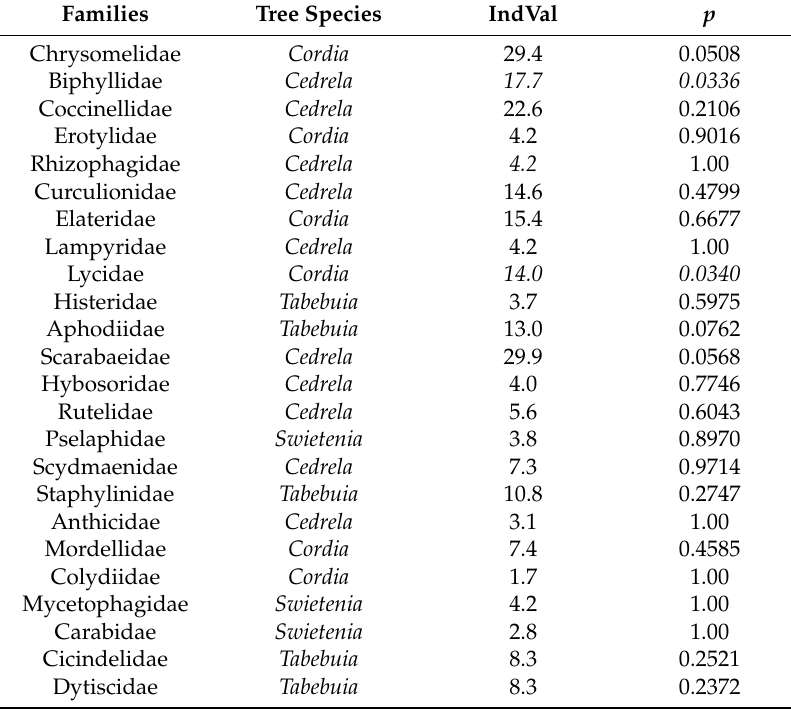
Table 6. Results obtained from the indicator species analysis in Coleoptera families associated to every native tree species in the study. In italics when significant ( p < 0.05). IndVal = indicator value.